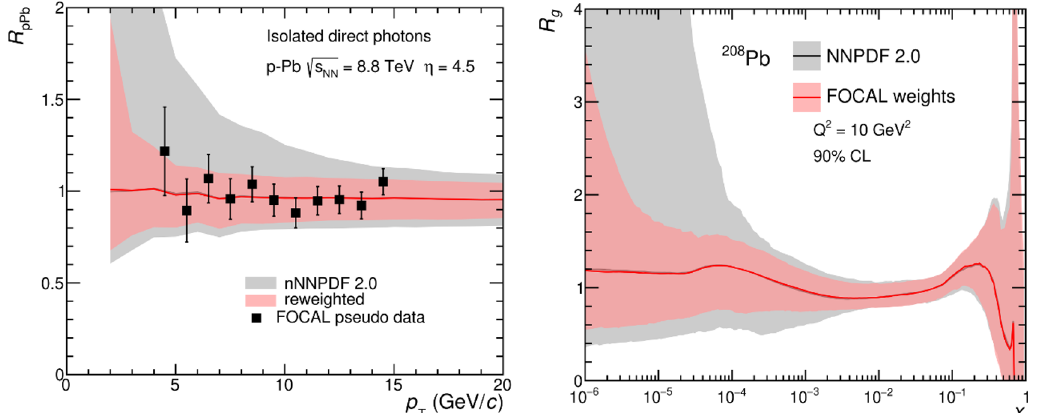
Figure 23 . Left: the nuclear modi(cid:12)cation factor R pPb ( p (cid:13) ) for direct photon production in pPb T p collisions at s = 8 : 8 TeV for a rapidity of (cid:17) (cid:13) = 4 : 5 as a function of the photon transverse momentum p (cid:13) . The theoretical predictions are compared with the FoCal pseudo-data for two T sets of input nPDFs: the original nNNPDF2.0 set, and the variant that has been reweighted with FoCal projections. Here the FoCal pseudo data assumes the central value of the nNNPDF2.0 prediction. Right: the gluon nuclear modi(cid:12)cation factor R g ( x; Q ) for Q 2 = 10 GeV 2 for both the original and the reweighted nNNPDF2.0 (cid:12)ts. The nPDF uncertainties correspond in both cases to the 90% con(cid:12)dence level